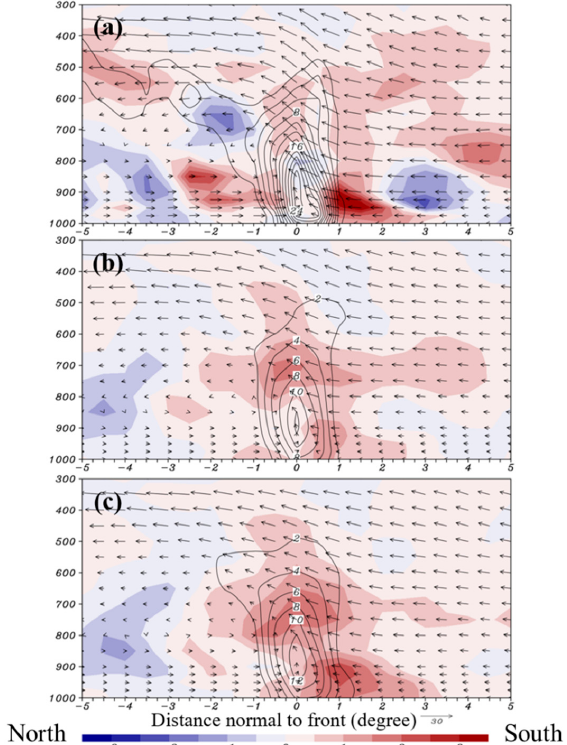
Figure 3. Vertical cross-sections averaged during the mature stage (from 0000 UTC 22 May to 0000 UTC 23 May 2020) of Mei-Yu front from ( a ) ERA5 reanalysis data and from the different initial date (from 0000 UTC 17 May to 0000 UTC 22 May 2020) in the ( b ) CTRL and ( c ) EXP experiments. Colored is the horizontal moisture advection (g kg − 1 6 h − 1 ). Contours are the relative vorticity (10 5 s − 1 ). Vectors are the vertical circulation perpendicular to the front (30 m s − 1 ). The frontal positions are determined by the maximum vorticity axes at 850-hPa. The cross-section is perpendicular to the front within ± 5 ◦ (positive toward the south) and is averaged along the frontal length. Further investigation of the variation of convective trigger effect with different ex- periments is shown in Figure 4. It indicates the contribution of the cumulus scheme (sub- grid-scale precipitation) and microphysics scheme (grid-scale precipitation) to the total precipitation. The frontal precipitation was mainly dominated by the grid-scale precipita- tion due to the grid cell-averaged relative humidity saturation, while the subgrid-scale precipitation was located at the leading edge of the frontal system (Figure 4a,b). A similar result was obtained by the EXP experiment (Figure 4c,d). However, the EXP produced larger convective precipitation at the leading age of the front, which reveals that more intense convection had been triggered. As a result, the microphysics scheme contributes to a more widespread and enormous grid-scale precipitation at the center of the Mei-Yu frontal system due to stronger horizontal moisture convergence. The results are in agree- ment with Figure 3.